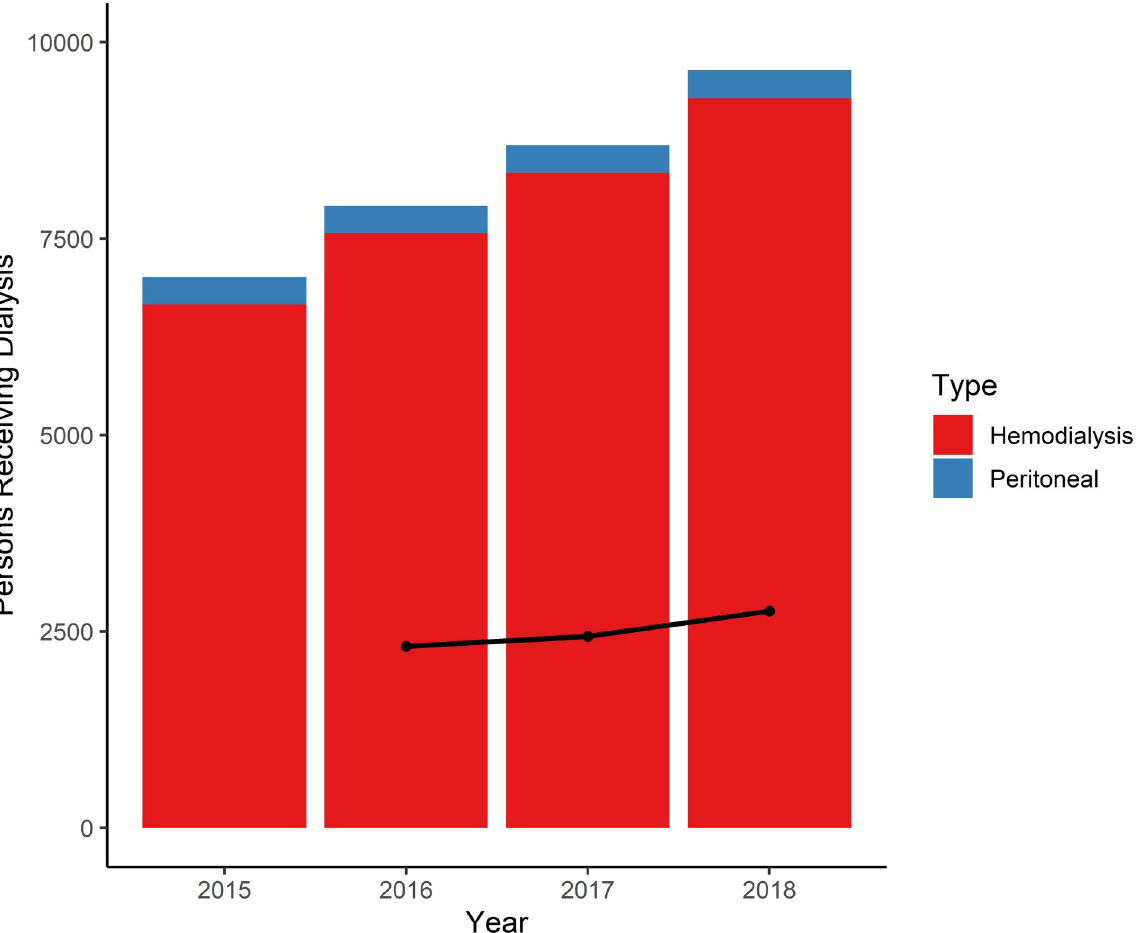
Fig 1. Number of IESS patients receiving dialysis, 2015–2018. Plot of patients in IESS system receiving dialysis each year from 2015–2018, by type: peritoneal (blue) and hemodialysis (red). The number of new patients annually is represented by the black line.